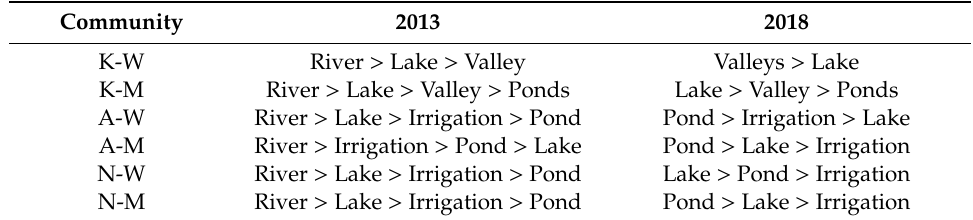
Table 4. Cultivation practices before (2013) and after (2018) Gibe III dam construction and thus after the annual flood